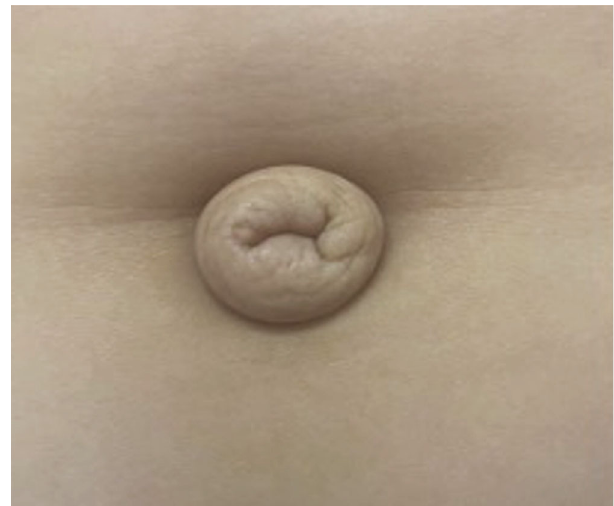
Figure 6: The existence of an everted